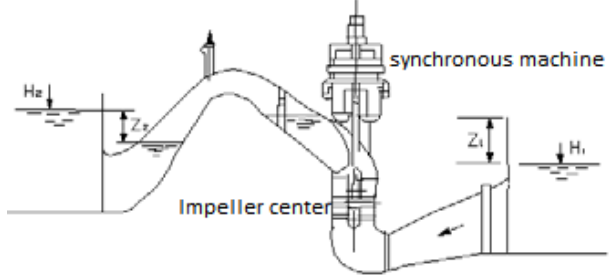
Figure 12. The pump system of Huaiyin second station [74].